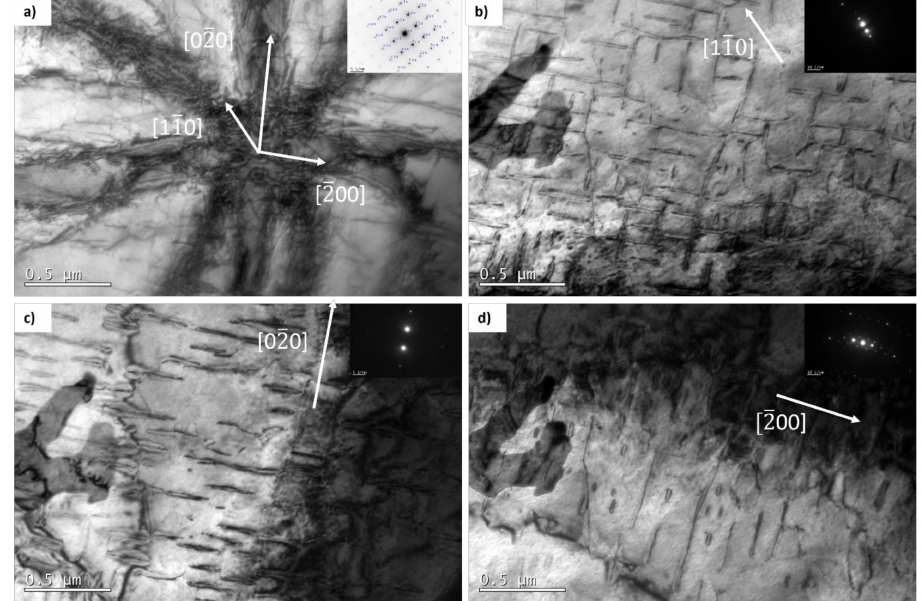
Figure 5. TEM micrographs of pure iron irradiated with 20 MeV at 300 ◦ C and high dose showing ( a ) bend contours under the [001] zone axis, and dislocation loops under ( b ) (110), ( c ) (020), and ( d ) (200) diffraction vectors.